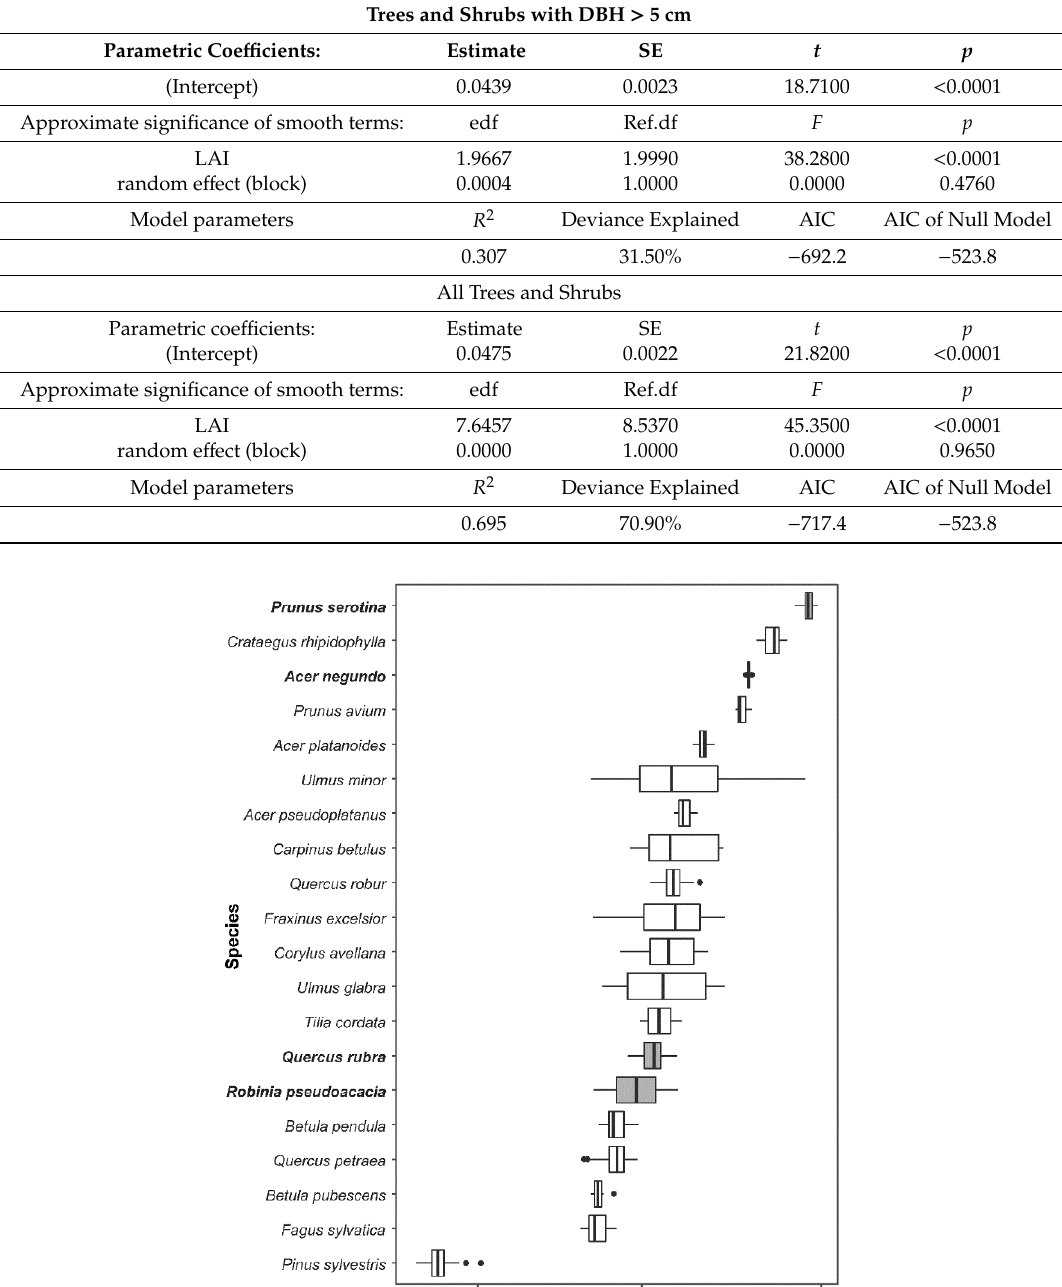
Table 1. GAM describing DIFN based on LAI and block (random effect accounting for study design). Akaike’s Information Criterion (AIC) of null model refers to a model with an intercept only, to express final model inertia. SE – standard error, edf—estimated degree of freedom, Ref.df—reference degree of freedom, used for F test for p -value computation.